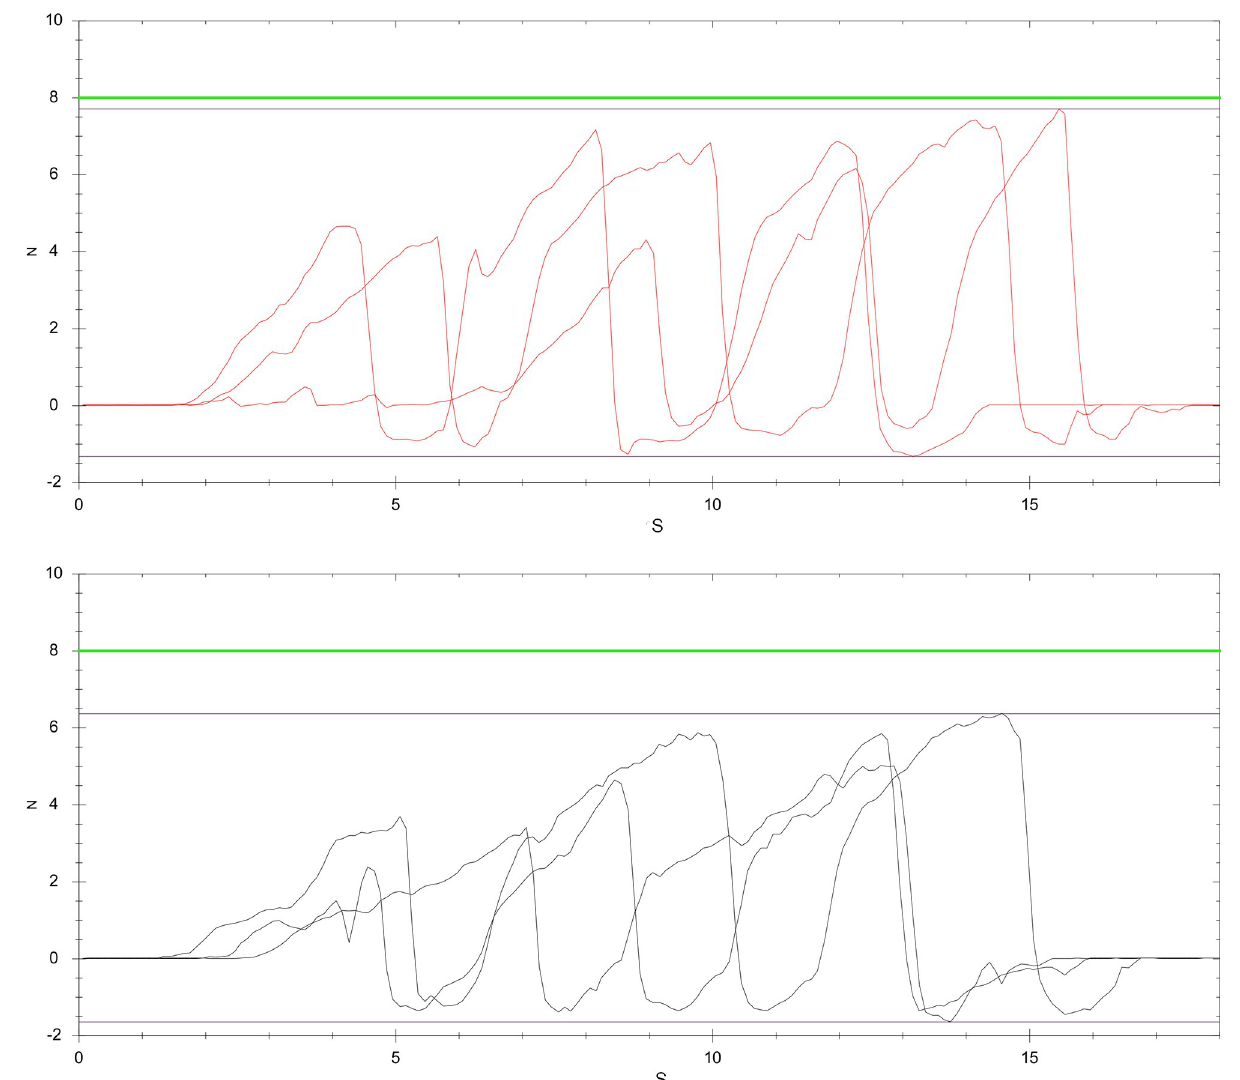
Fig 2. Axial forces applied during root canal preparation of one specimen with peak values between 4 N and 8 N. Red: 25/.06; black: